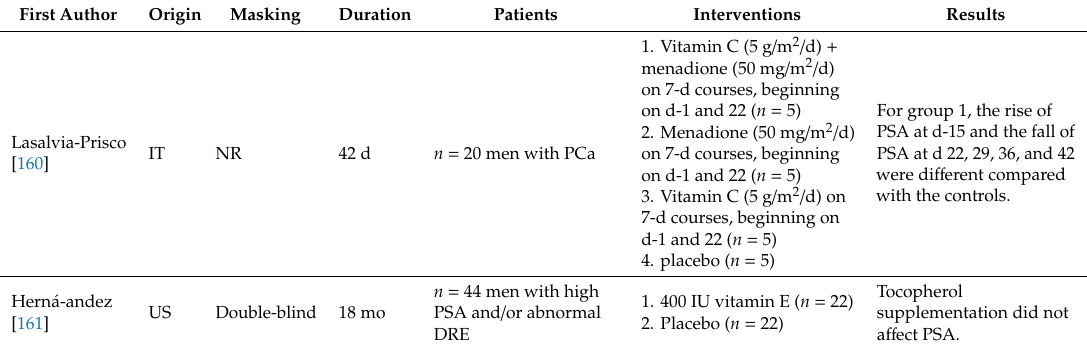
Table 8. RCTs examining the e ff ect of vitamin C, or α -tocopherol ONS on PSA concentrations among men with PCa or increased PCa